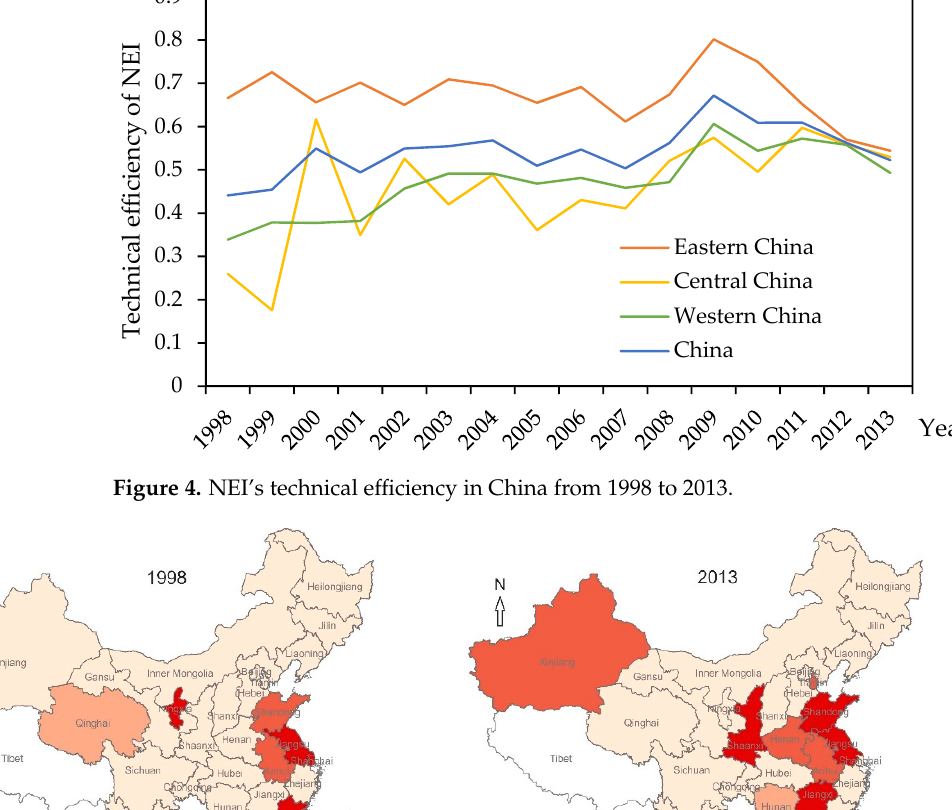
Figure 5. The spatial distribution of NEI’s provincial technical efficiency across China in 1998 and 2013.